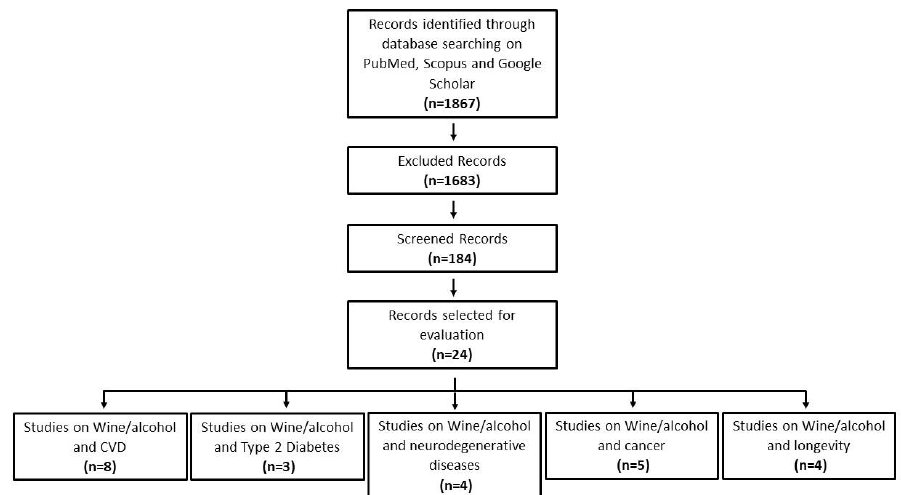
Figure 1. Flowchart of literature search on epidemiological studies .